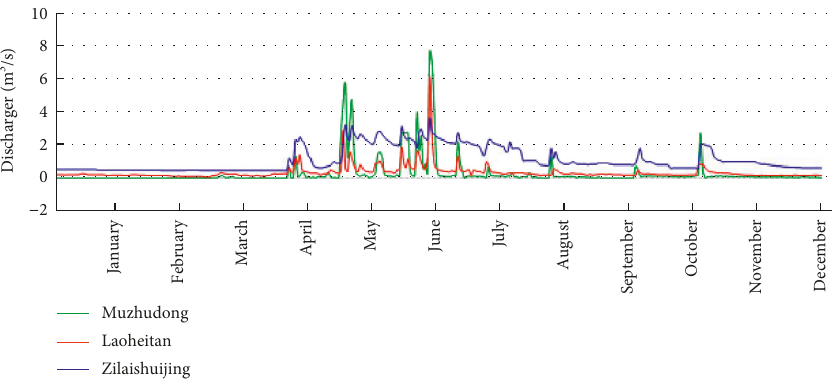
Figure 4: Discharge hydrograph of Houzhai karst water in